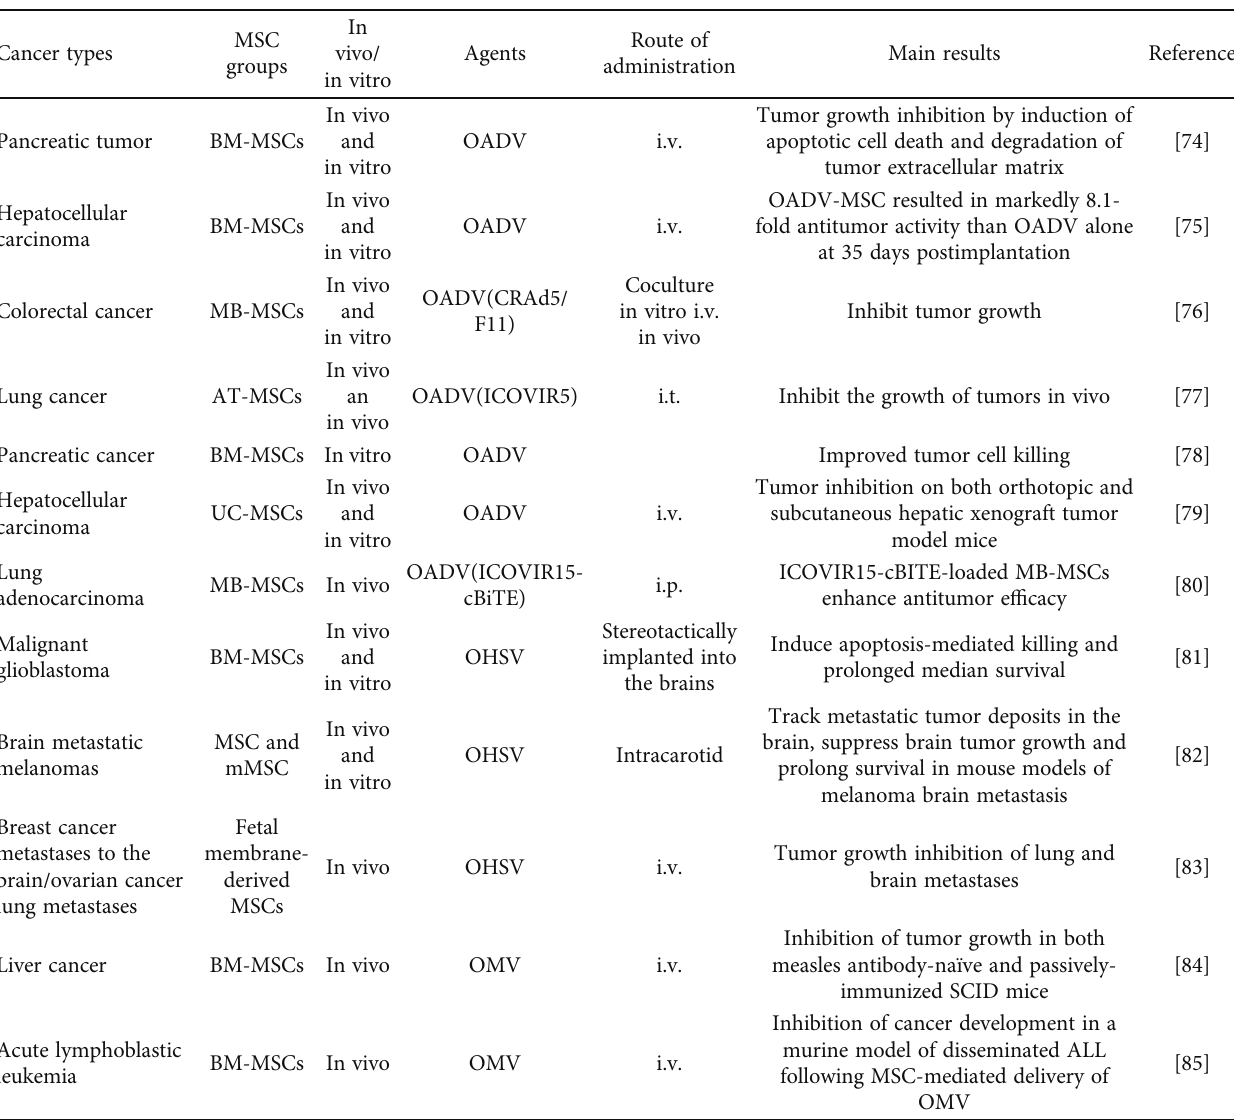
Table 4: MSC as delivery of oncolytic